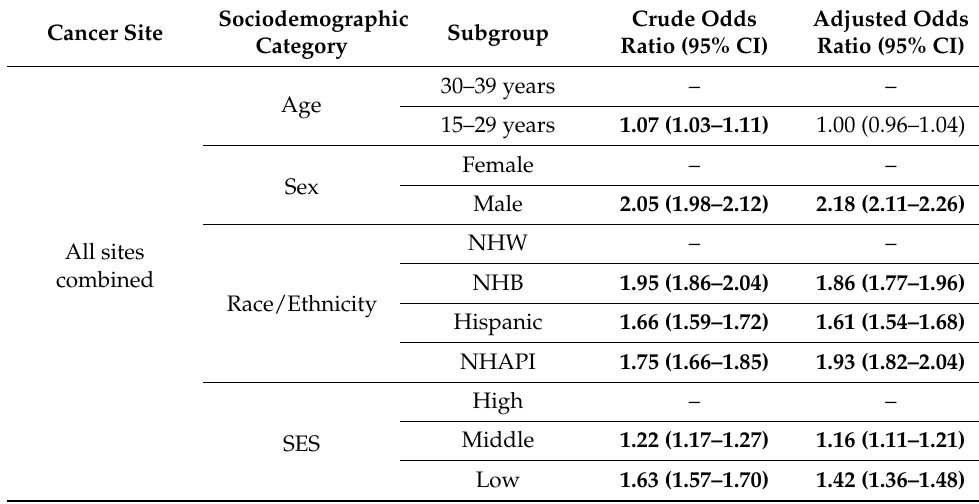
Figure 1. ( a ) Stage distribution for poor-prognosis metastatic cancers in aggregate. ( b ) Proportion of metastatic disease by cancer site. Total percentage in Figure 1A is greater than 100 due to rounding to nearest whole number. Table 1. Proportion of Metastatic Disease by Sociodemographic Subgroup: Surveillance, Epidemi- ology, and End Results Program (2000–2016). Table 2. Crude and Adjusted Odds Ratio for Metastatic Disease Presentation: Surveillance, Epidemi- ology, and End Results Program Cancer Site